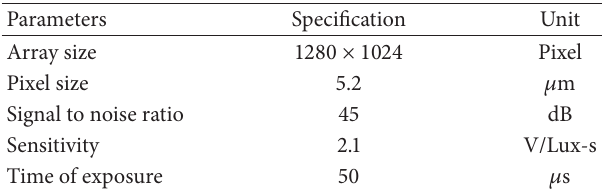
Table 2: The specifications of the